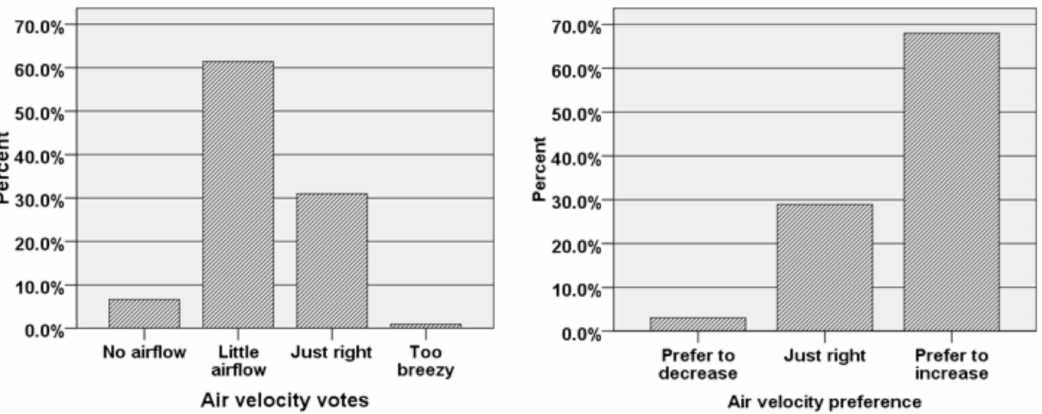
Figure 7. Students’ responses to the air velocity ( left ) and their preference ( right